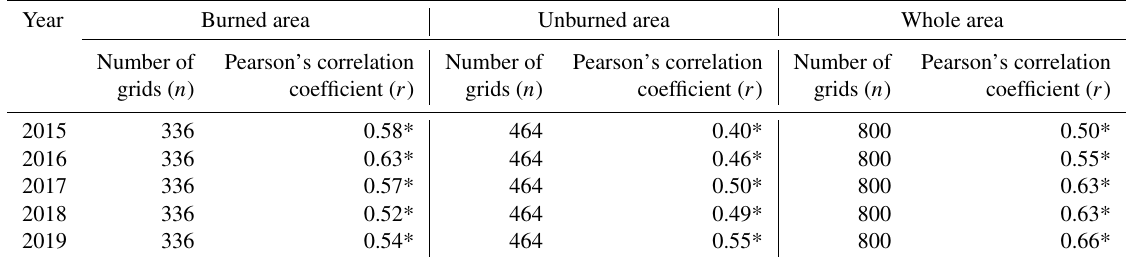
Table 3. Pearson’s correlation coefficient calculated between modeled GPP and MODIS GPP for the burned, unburned, and whole area.